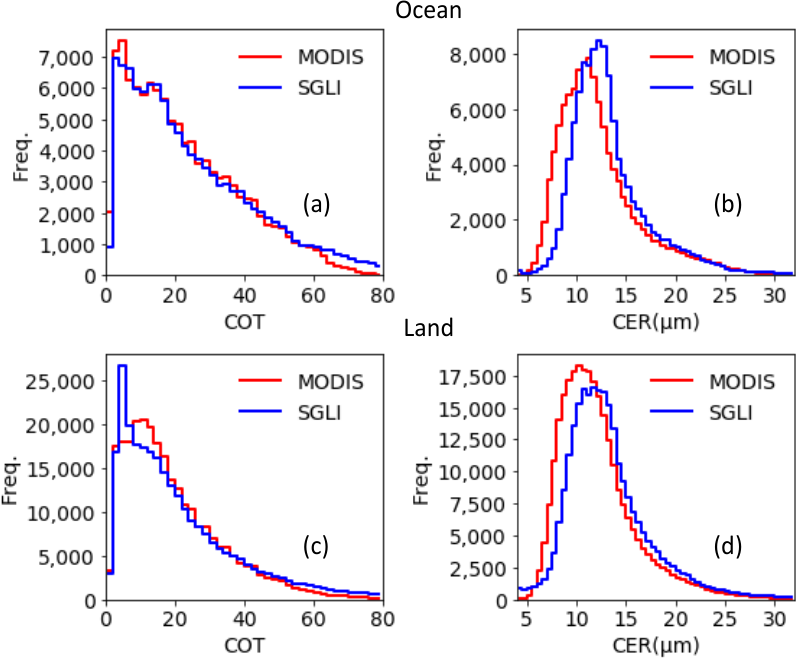
Figure 2. Frequencies of ( a ) COT over ocean, ( b ) CER over ocean, ( c ) COT over land, and ( d ) CER over land for MODIS (red) and SGLI (blue) for water cloud pixels. 3.2.2. Ice Clouds Figure 3 shows the comparisons of COT (left) and CER (right) between SGLI and MODIS for pixels detected as ice clouds by both satellite sensors for ocean surface (left) and land surface (right). Figure 3 suggests that COT and CER values obtained from MODIS and SGLI observations can agree better over the ocean surface than over the land